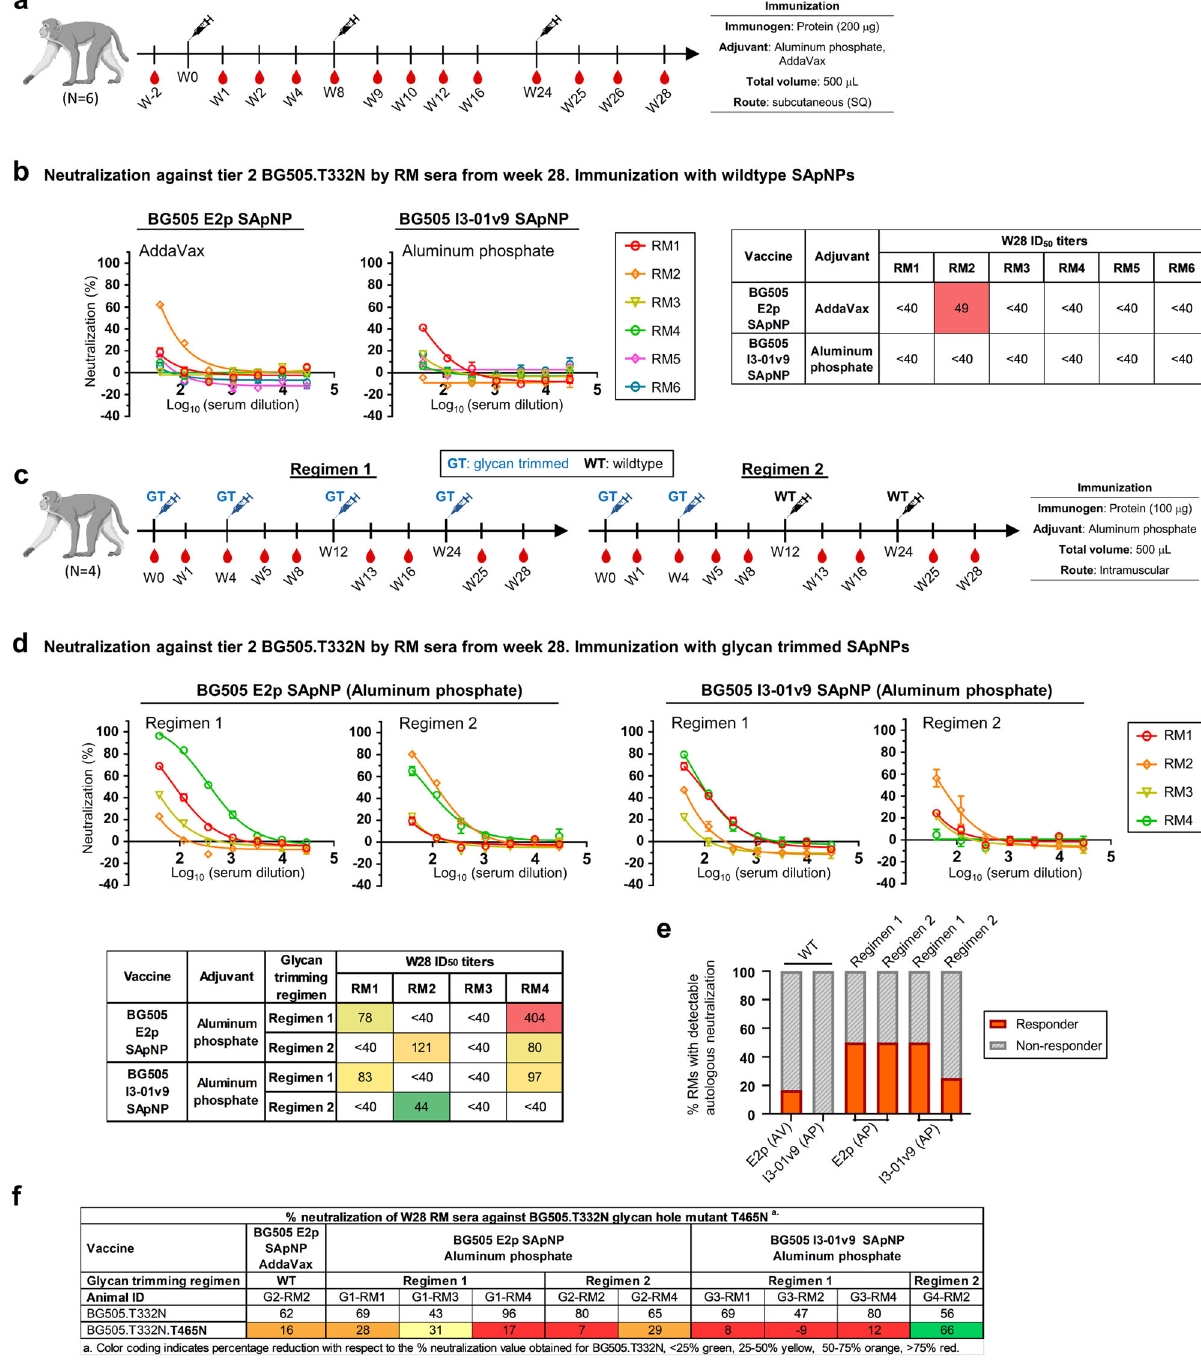
Fig. 7 | Immunogenicity of BG505 UFO Env immunogens with wildtype and trimmed glycans in NHPs. a Schematic representation of the immunization regi- men for wildtype BG505 UFO trimer-presenting E2p and I3-01v9 SApNPs. E2p was formulated with AddaVax and I3-01v9 with aluminum phosphate. b Neutralization of tier 2 clade A BG505.T332N by rhesus macaque (RM) sera from week 28 ( n =6 RMs/group). Neutralization curves and ID 50 titers are shown. c Schematic repre- sentation of immunization regimen 1, where glycan-trimmed immunogens were usedthroughout,andregimen2,whereglycan-trimmedandwildtypeimmunogens wereusedasprime(doses1and2)andboost(doses3and4),respectively.SApNPs were formulated with aluminum phosphate for all groups in both regimens. d Neutralization of tier 2 clade A BG505.T332N by NHP sera from week 28 ( n =4